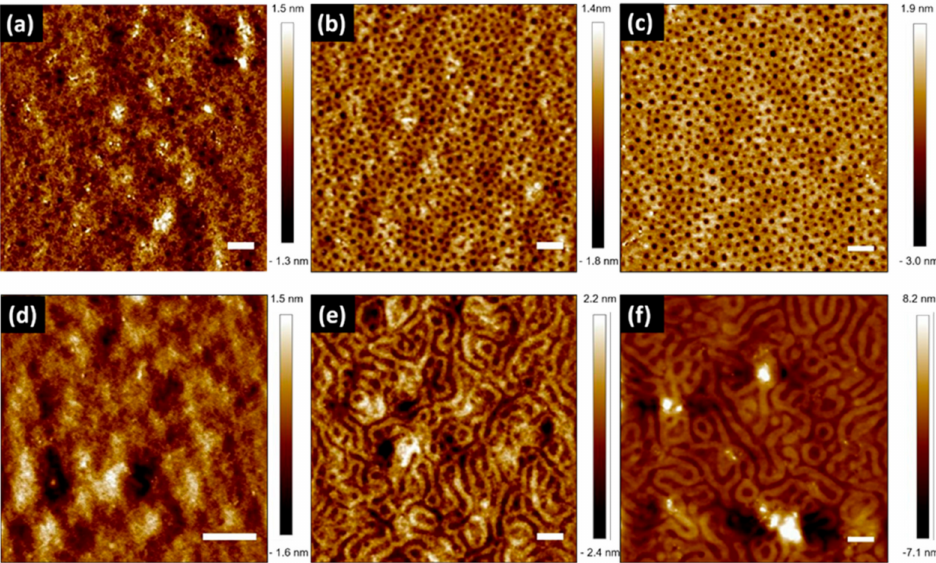
Figure 2. AFM height images of P1 ( a – c ) and P3 ( d – f ) spin-cast from chlorobenzene solution onto Si substrate. ( a , d ) as-cast with spin-coating at room temperature; ( b , e ) as-cast with spin-coating on heated Si substrate; ( c , f ) annealed in chloroform vapor for 5 min after spin-coating on heated Si substrate. Scale bars are 200